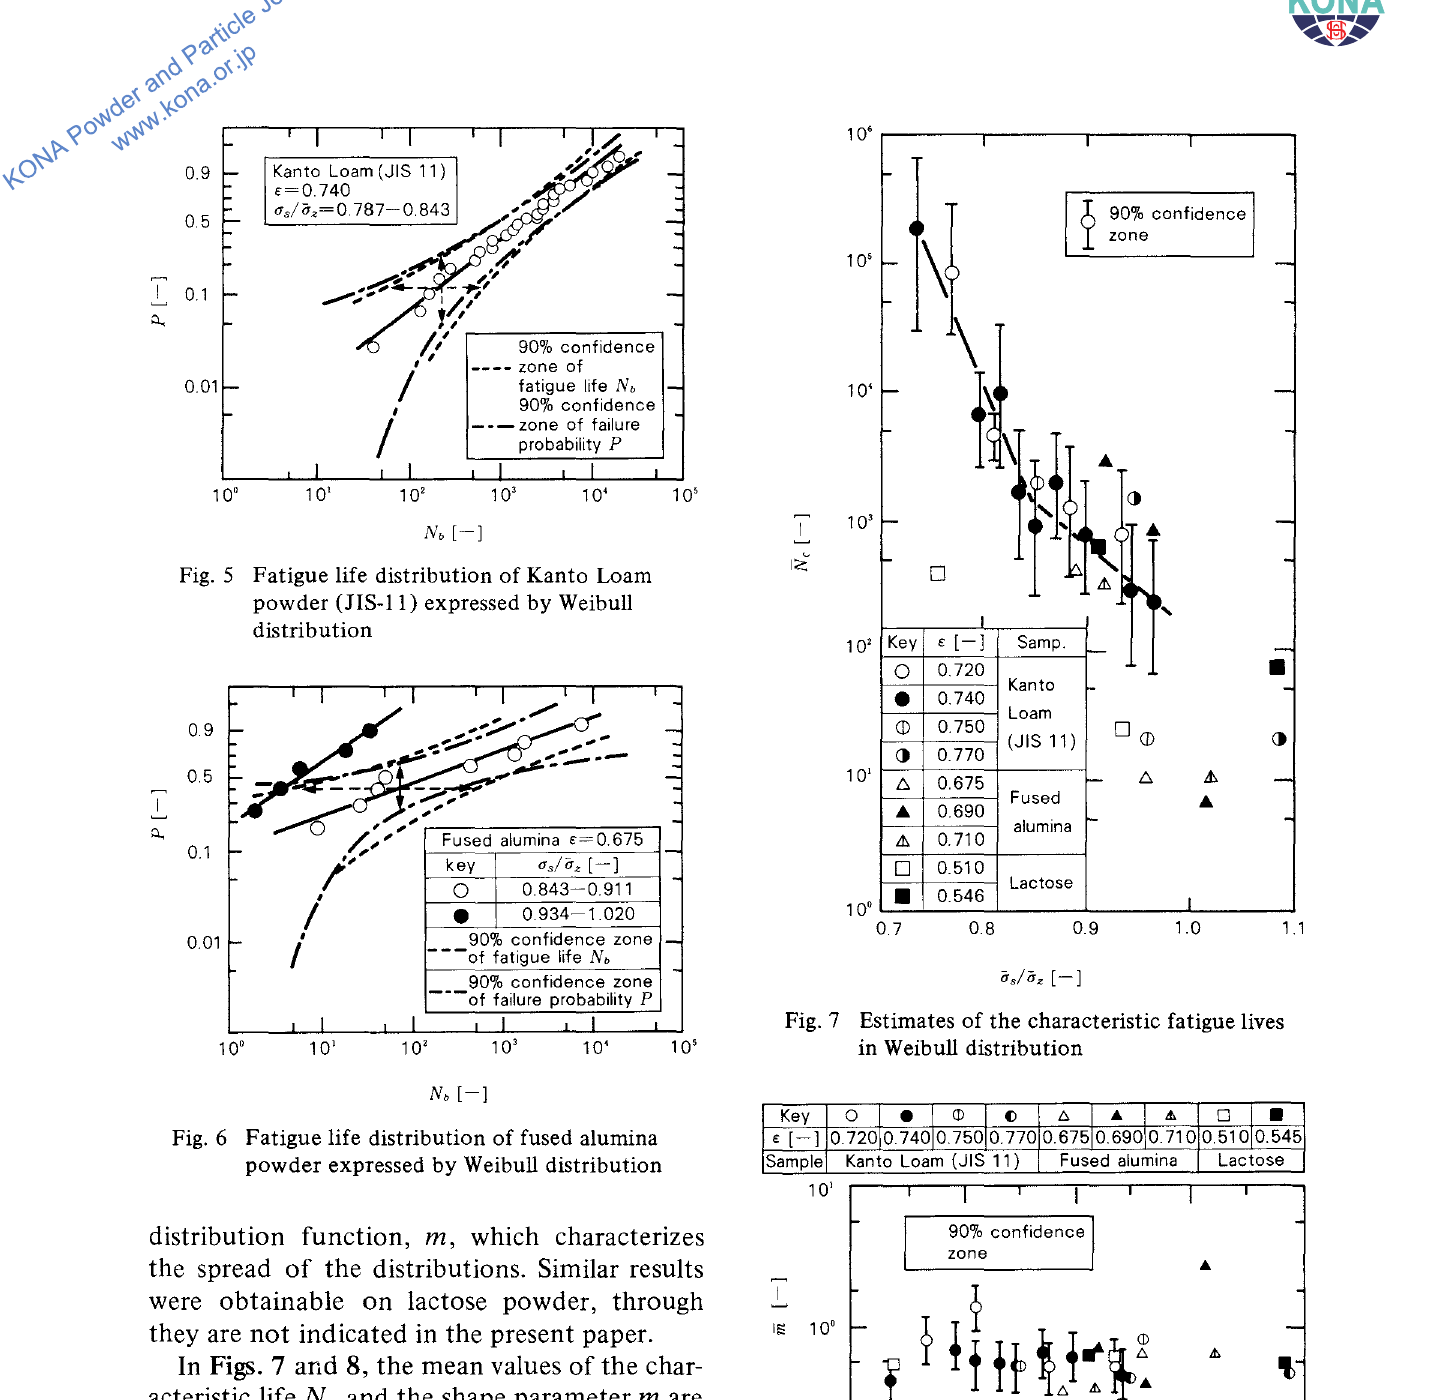
Fig. 6 Fatigue life distribution of fused alumina powder expressed by Weibull distribution